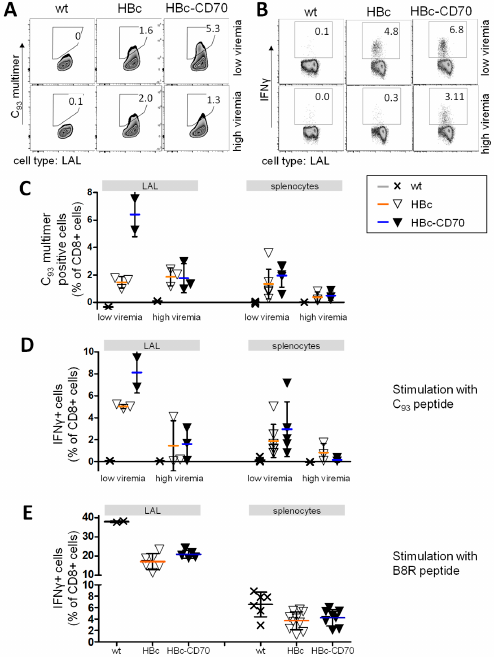
Figure 4. Amount and functionality of CD8 T cells in the livers and spleens of vaccinated HBV1.3tg mice with and without CD70 co-expression. HBV1.3tg mice were immunized with protein-prime (day 0, HBc + CpG + PCEP, group wt only CpG and PCEP) and MVA boost (day 21, with MVAwt (group wt), rMVA-HBc (group HBc) or rMVA-HBc-CD70 (group HBc-CD70)). Mice were divided into groups with low to moderate HBeAg levels (1–8 S/CO, “low viremia”) and high antigen levels (8–23 S/CO, “high viremia”) before the experiment. At day 35, splenocytes and liver-associated lymphocytes of mice were isolated. ( A ) Representative dot blot analysis of liver-associated lymphocytes (LAL) for single mice of each vaccination group, utilizing C 93 multimer staining. ( B ) Representative dot blot analysis of intracellular cytokine staining (IFN γ ) after ex vivo C 93 stimulation of LALs. ( C ) Percentages of C 93 multimer-positive CD8 T cells in vaccinated mice. ( D ) HBV core-specific CD8 T cell response for the groups of mice with low and high viremia represented by the portion of CD8 T cells expressing IFN γ after ex vivo stimulation with C 93 peptide. ( E ) MVA-specific CD8 T cell response represented by the portion of CD8 T cells expressing IFN γ after ex vivo stimulation with B8R peptide. Mice with low and high viremia are presented together. C 93 : HBV core-derived CD8 T cell epitope; B8R: MVA-derived CD8 T cell epitope; Crosses and triangles represent individual mice; Horizontal lines indicate mean values; Error bars indicate standard deviation. Differences between groups HBc and HBc-CD70 (if >2 mice/group) were not statistically significant (one-way ANOVA and unpaired